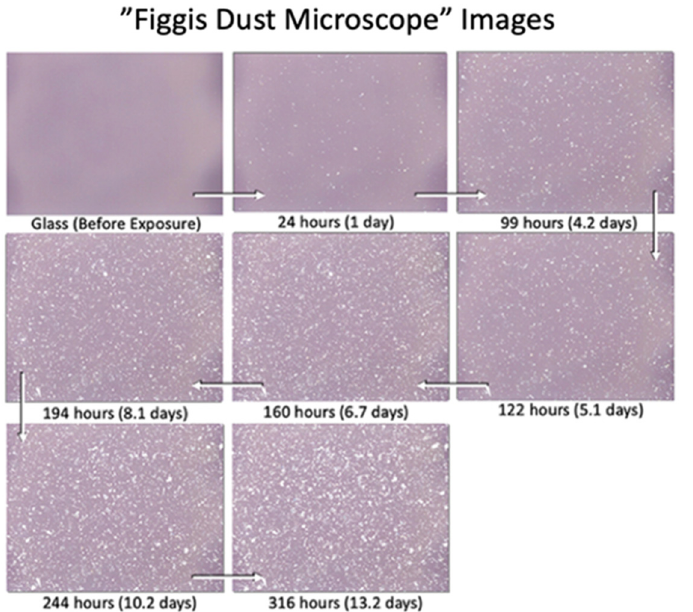
Figure 6. Figgis dust microscope images of soiling layers on module glass as a function of exposure time in Belo Horizonte, Brazil [41,44]. Particle-size distribution peak is about 10 µ m, and gravimetric densities are those represented in Figure 7.